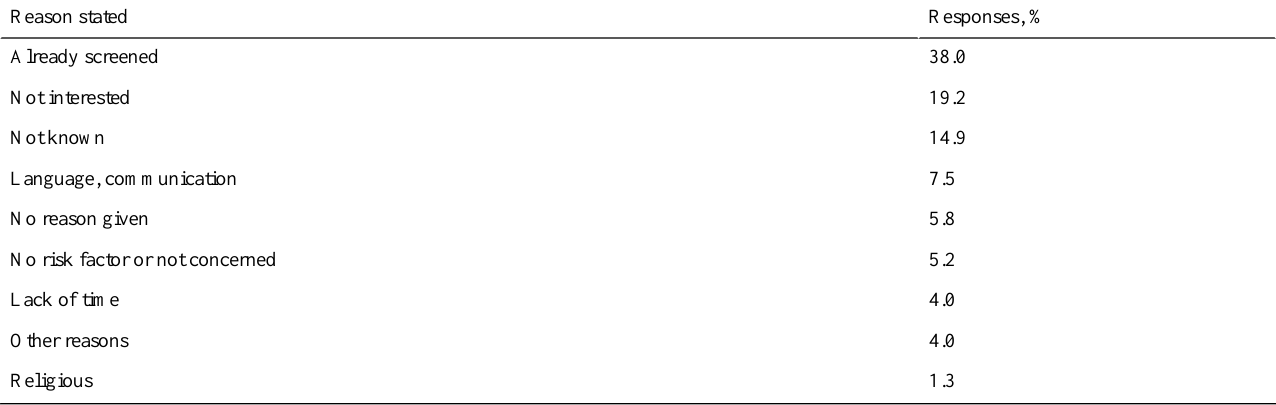
Table 2. Reasons migrants refuse screening when it is